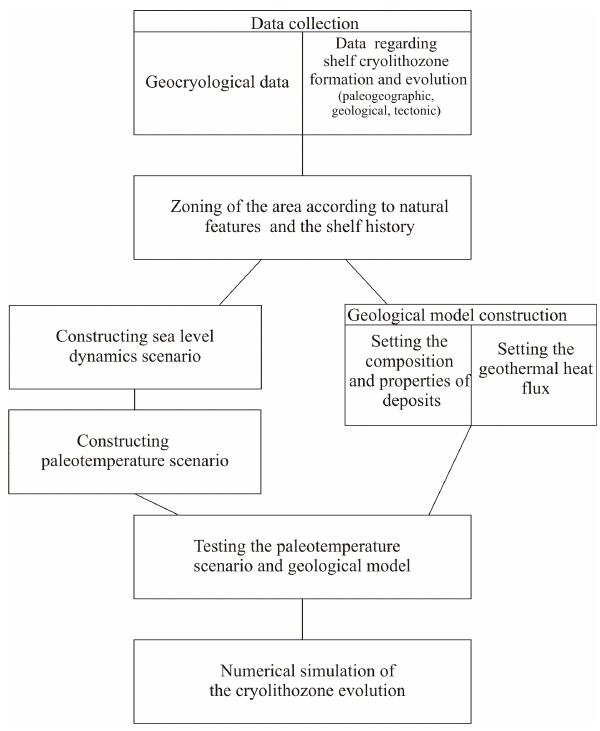
Figure 1. The general scheme of the